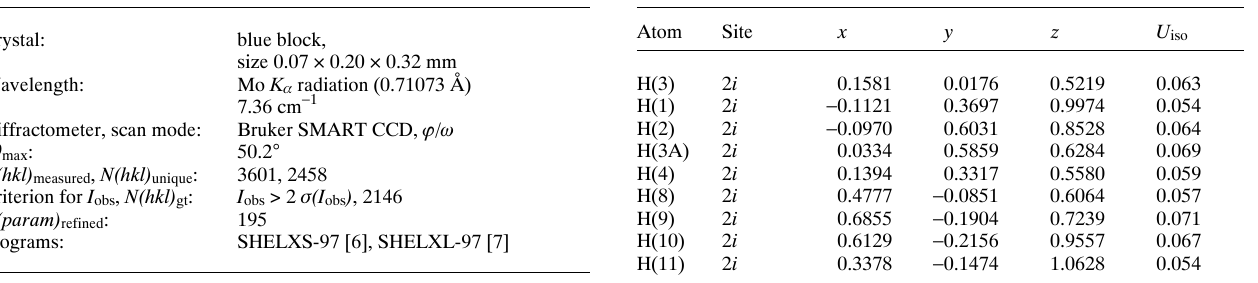
Table 2. A tomic coordin a tes a nd displ a cement p a r a meters (in Å 2 ) . Table 1. D a t a collection a nd h a